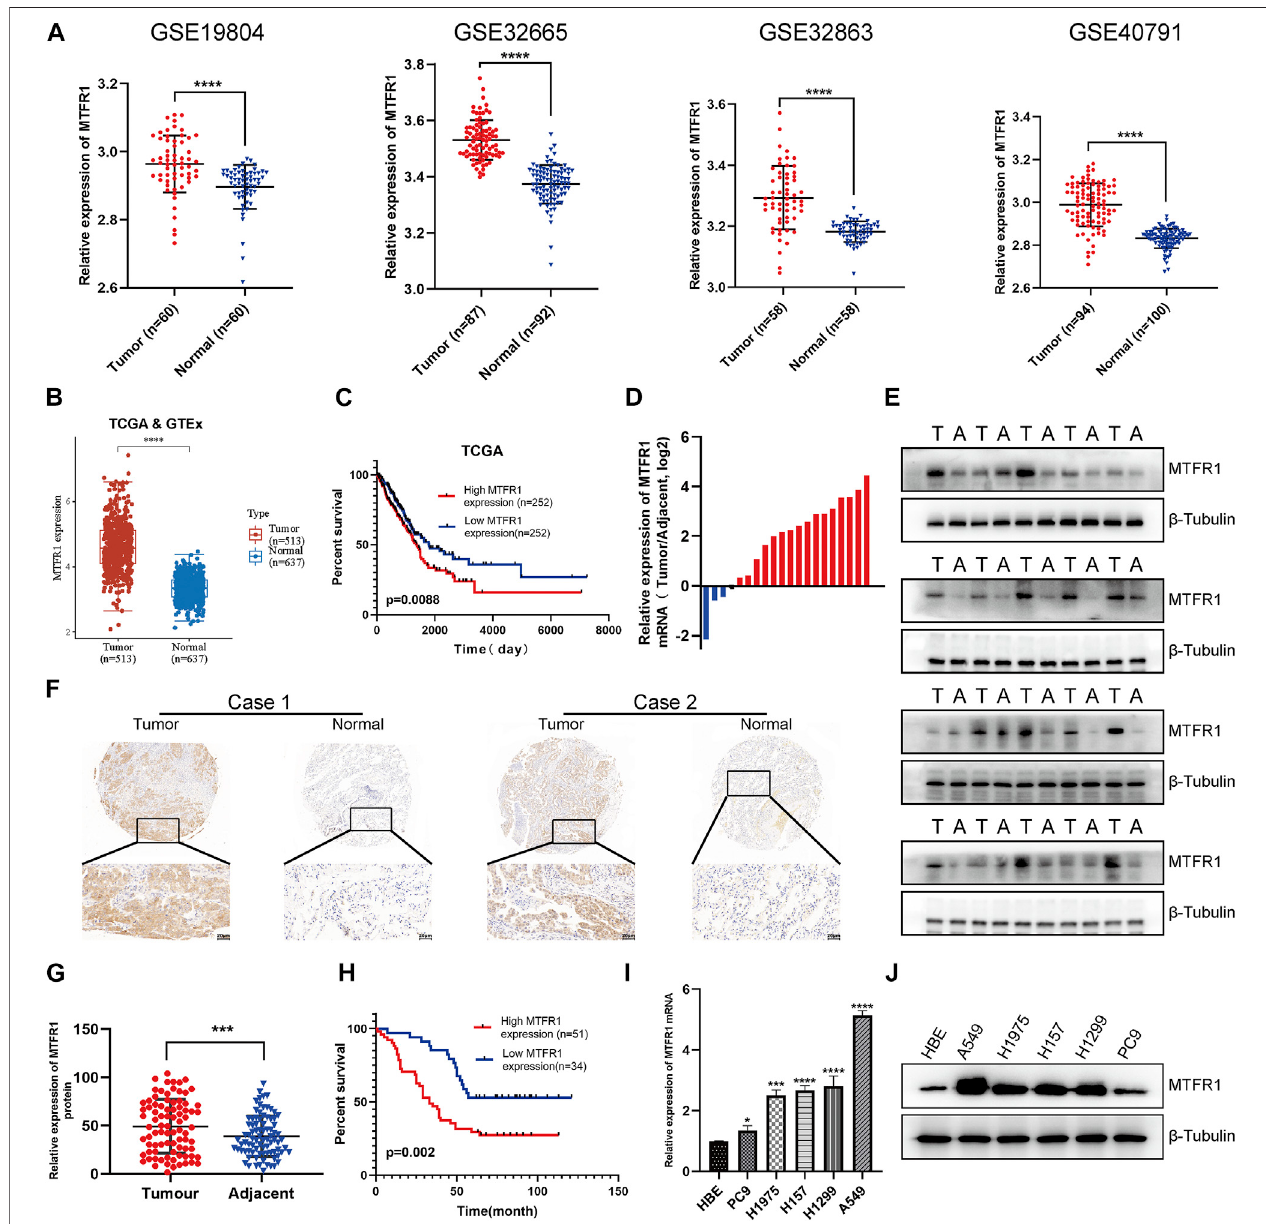
FIGURE1| Mitochondrial fi ssionregulator1(MTFR1)wasoverexpressedinlungadenocarcinoma(LUAD)celllinesandtissues. (A) TheexpressionlevelsofMTFR1 in four Gene Expression Omnibus (GEO) datasets. (B) MTFR1 expression levels in The Cancer Genome Atlas (TCGA) and Genome – Tissue Expression (GTEx) databases. (C) Kaplan – Meier (KM) analysisforTCGA-LUAD samples. (D,E) Therelative mRNA and protein expression ofMTFR1 in20pairs ofLUADtumour (T)tissues and their matching adjoining (A) normal tissues. (F) Representative immunohistochemical images of LUAD and adjacent nonmalignant specimens stained for analysing MTFR1 expression. (G) The immunohistochemical score of 85 pairs of LUAD tissues and adjoining paracancerous tissues ( p < 0.001). (H) Kaplan – Meier survivalanalysesof85patients withLUAD. (I,J) Therelative protein andmRNAexpression ofMTFR1indifferentcelllines.Datawerearticulated asthemean ± standard deviation (SD; * p < 0.05, *** p < 0.001, **** p < 0.0001).